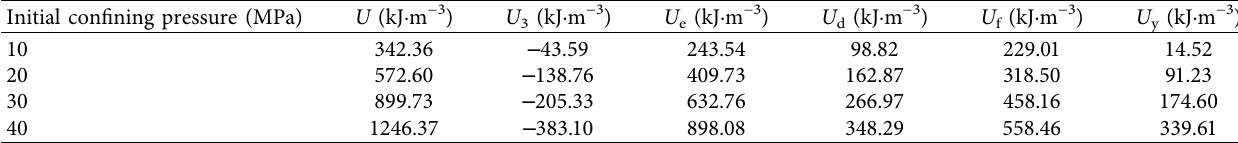
Table 3: Energy transformation of sandstone unloading failure under different initial confining pressures. Initial confining pressure